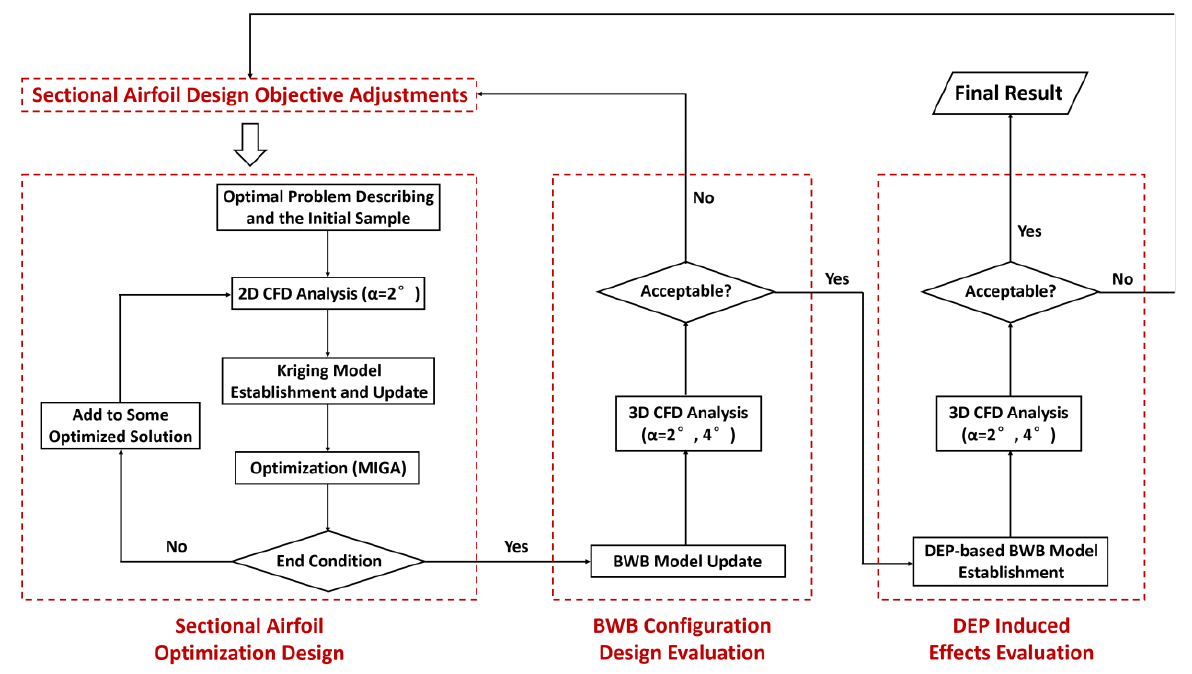
Figure 9 . BWB configuration optimization design framework under DEP installation constraints. Figure 9. BWB configuration optimization design framework under DEP installation